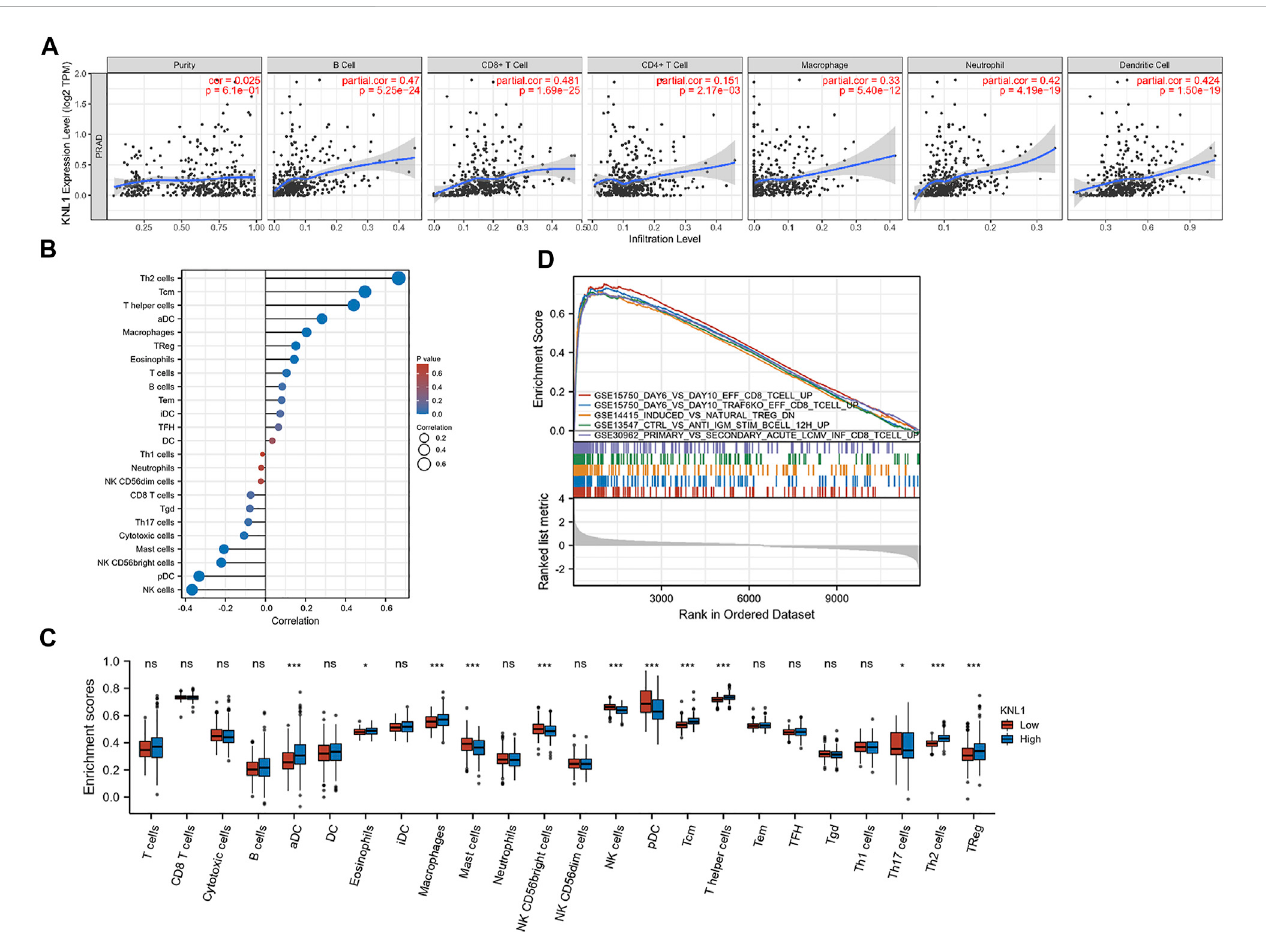
FIGURE 6 Correlation between KNL1 expression and TIICs. (A) Correlation between KNL1 expression and six types of immune cells in the TIMER database. (B) Lollipop graphs of correlation between KNL1 and biomarkers of 24 immune cells. (C) The distribution of 24 subtypes of immune cells in low and high KNL1 expression group. (D) GSEA analysis of differential genes in immune-related datasets by single-gene analysis. (Ns: no signi fi cance; * p < .05; ** p < .01; *** p <